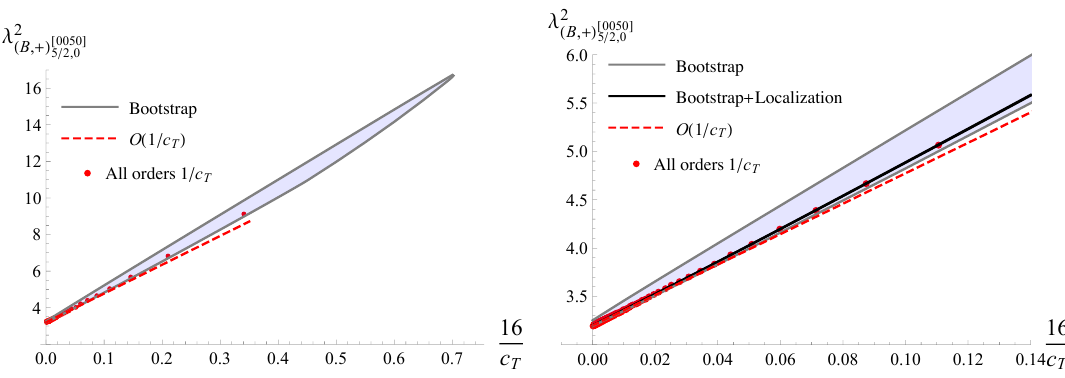
Figure 1 . Upper and lower bounds on the ( B, +) [0050] OPE coefficient squared in terms of the 5 / 2 , 0 stress-tensor coefficient c T for the full range of c T ( left ) and in the large c T regime ( right ). The gray lines are bounds from mixed correlators of S 2 and S 3 with bootstrap precision Λ = 35 , while the black lines come from the same setup but with the OPE coefficients of all short multiplets except ( B, +) [0050] imposed using their all orders in 1 /c T expressions from localization. The red 5 / 2 , 0 dotted line denotes the large c T expansion to order tree level supergravity O ( c − 1 ) , while the red T dots denote the all orders in 1 /c T expression for integer values of N starting with the interacting sector of U(3) 1 × U(3) − 1